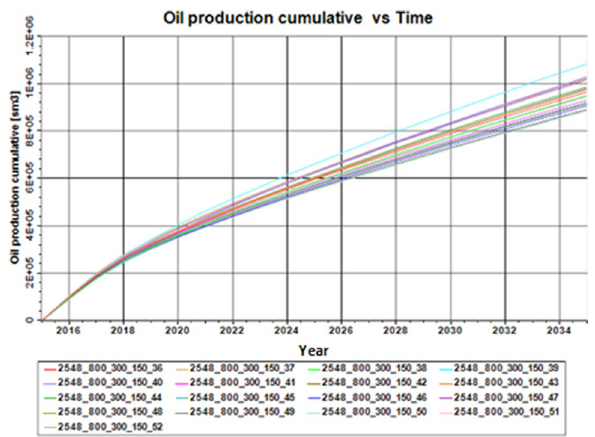
Fig. 10 Comparison of oil production cumulative for different nozzle sizes